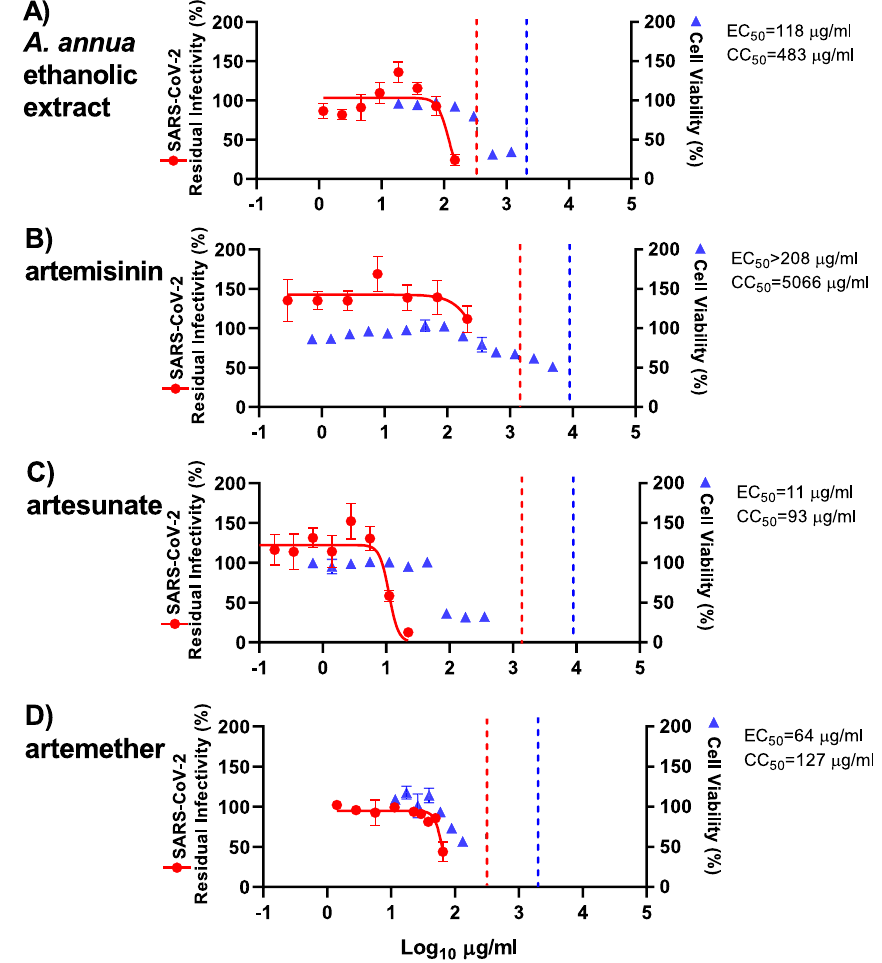
Figure 4. Treatment efficacy of A. annua extract and compounds against SARS-CoV-2 in a concentration– response antiviral treatment assay in Huh7.5 cells. Huh7.5 cells seeded the previous day in 96-well plates were infected with SARS-CoV-2 and directly treated with the specified concentrations of A. annua ethanolic extract ( A ) or compounds artemisinin ( B ), artesunate ( C ), and artemether ( D ). After a 3-day incubation, infected cells were visualized by immunostaining for SARS-CoV-2 spike glycoprotein and counted automatically as described in “Materials and methods”. % residual infectivity for individual wells was calculated by relating counts of infected treated wells to the mean count of 14 infected nontreated control wells. Datapoints (red dots) are means of seven replicates with SEM obtained in one representative experiment. Sigmoidal dose response curves (red lines) were fitted and EC 50 values were calculated in GraphPad Prism as described in “Materials and methods”. % Cell viability and CC 50 values were determined in replicate assays without infection with SARS-CoV-2 as described in “Materials and methods”. Datapoints (blue triangles) are means of 3 replicates with SEM obtained in one representative experiment. The dotted red/blue lines indicate the concentrations at which an antiviral effect (< 70% residual infectivity)/cytotoxic effect (< 90% cell viability) due to DMSO is expected according to Figure